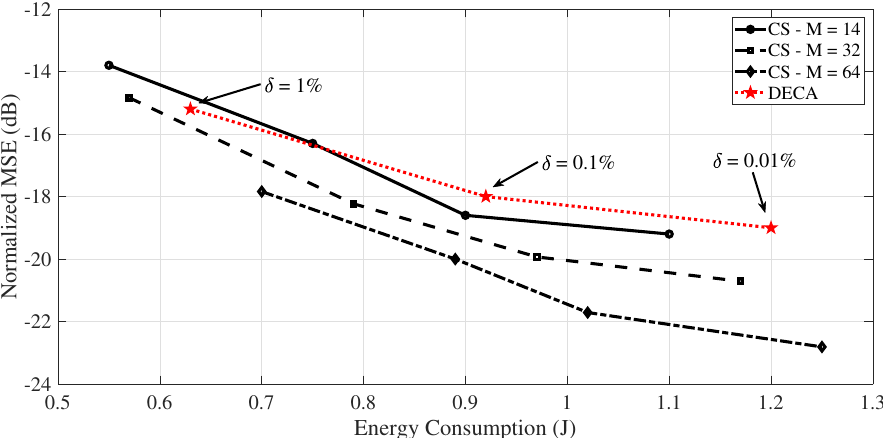
Figure 5. A comparison of the energy consumption between both distributed energy conservation algorithm (DECA) and CS schemes, applied to the reconstruction of N = 512 samples of a temperature